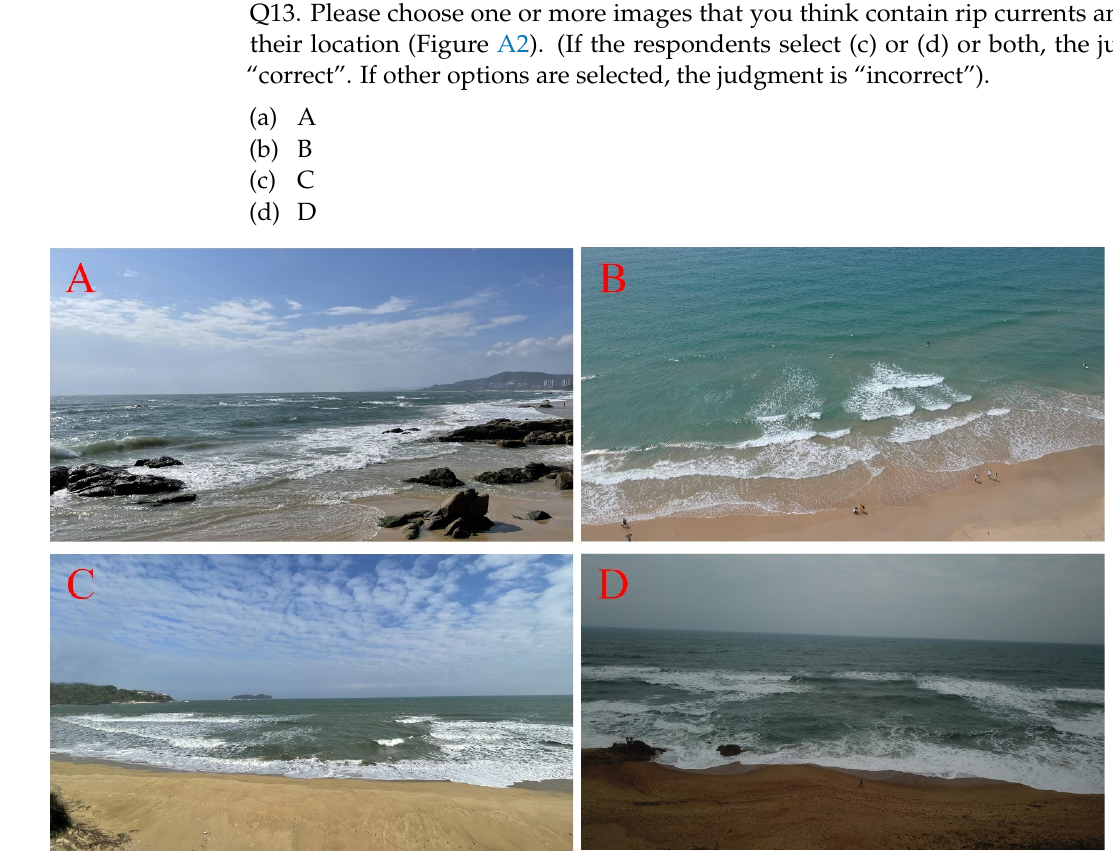
Figure A1. Some rip current warning signs on the beach in Sanya, China.